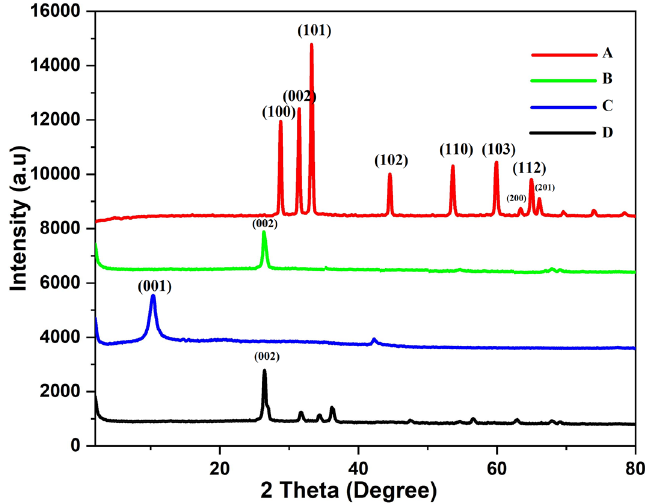
Figure 1. X-ray diffraction pattern depicting peak-indices and 2θ values of ( A ) ZnO NPs, ( B ) GN ( C ) GO and ( D ) GN:ZnO